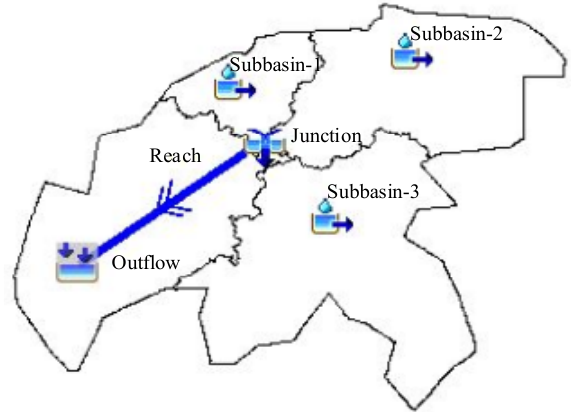
Figure 4. Schematic diagram for the HEC ‐ HMS model setup.